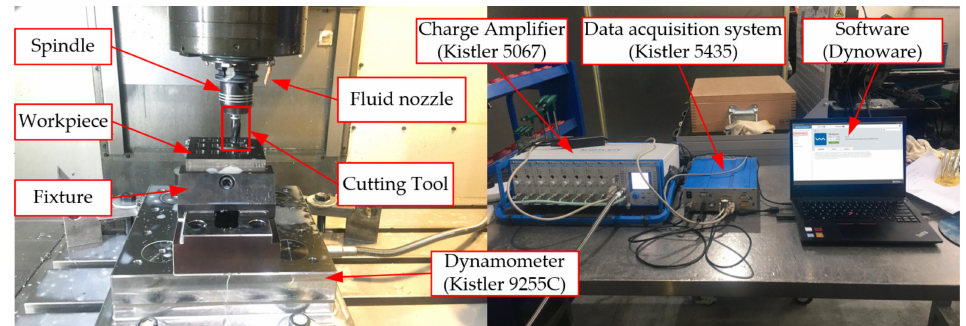
Figure 1. Experimental